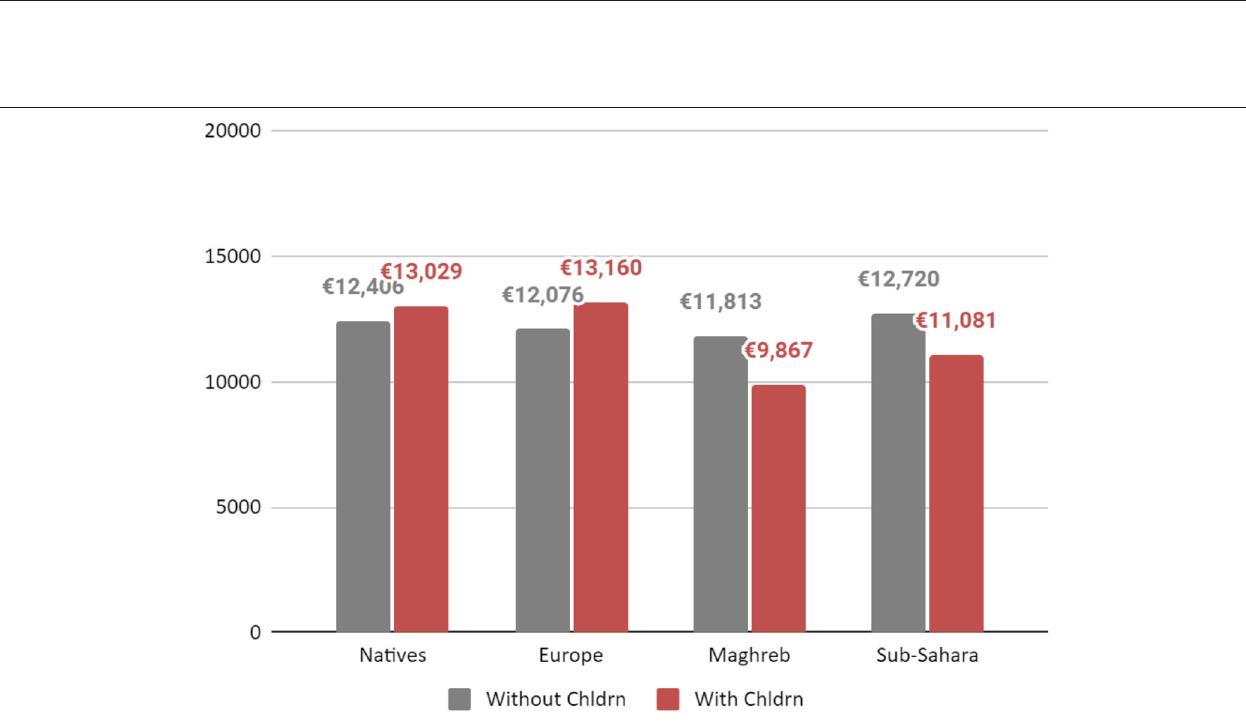
Frontiers in Sociology |